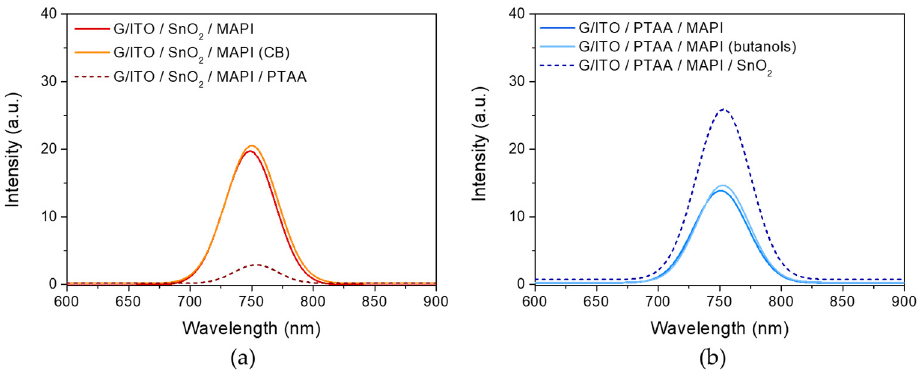
Figure 3. Photoluminescence (PL) spectra of the CH 3 NH 3 PbI 3 (MAPI) perovskite obtained from ( a ) NIP- and ( b ) PIN-type architectures with three different conditions: stacks up to the perovskite layer, the same stacks above which the n + 1 film was deposited (PTAA for NIP and np-SnO 2 for PIN), and, finally, stacks above which only the respective solvent of the corresponding solutions was spin-coated but without any PTAA and np-SnO 2 .